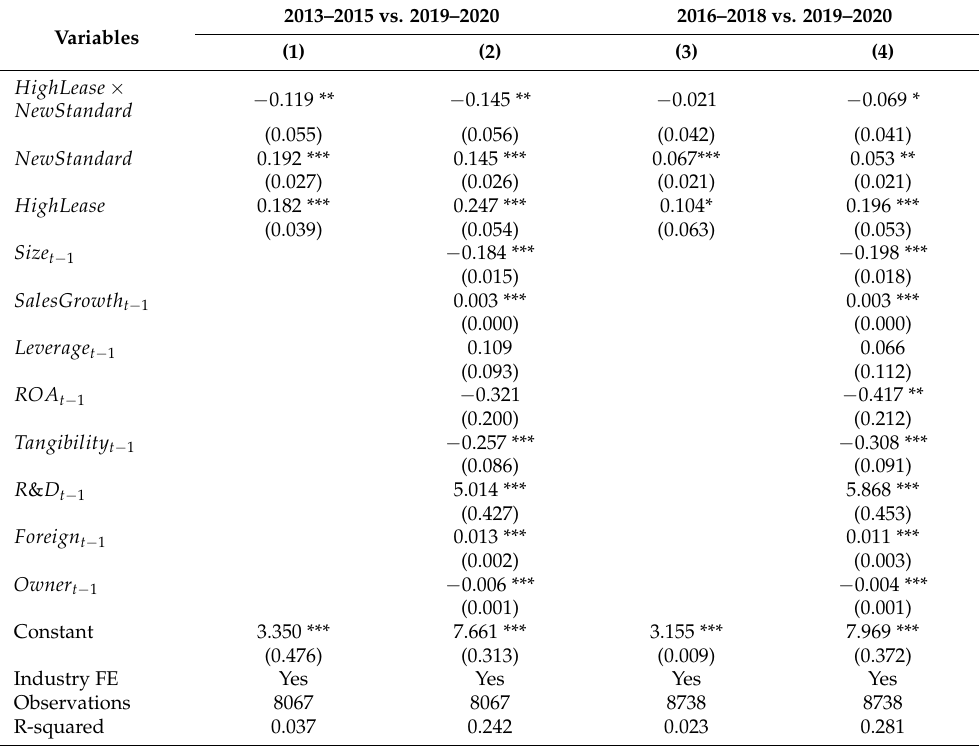
Table 5. The effect of K-IFRS 1116 on firm value. This table documents the effect of K-IFRS 1116 on firm value. The dependent variable is Tobin (cid:48) s q . Standard errors are clustered at the firm level and are reported in parentheses. *, **, and *** denote statistical significance at the 10%, 5%, and 1% levels,